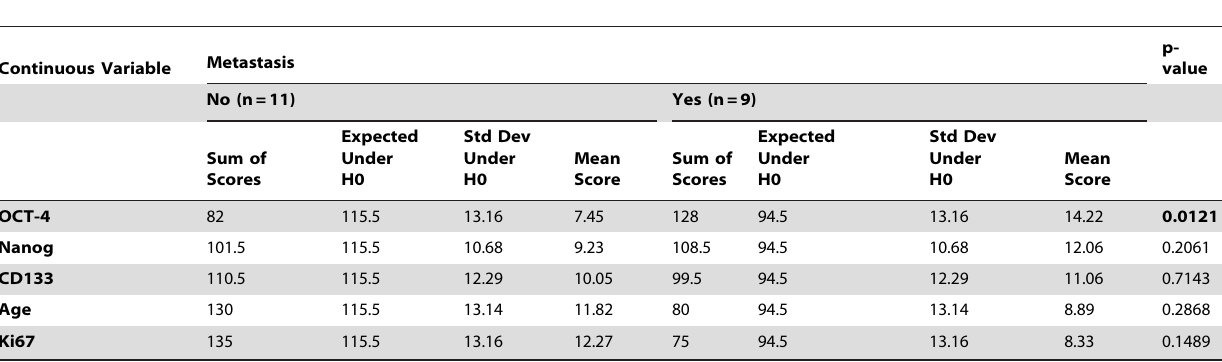
Table 3. Univariate analysis for correlation between metastasis and immunoexpression of three CSC-representative markers, age and Ki67 in 20 patients with MPE.